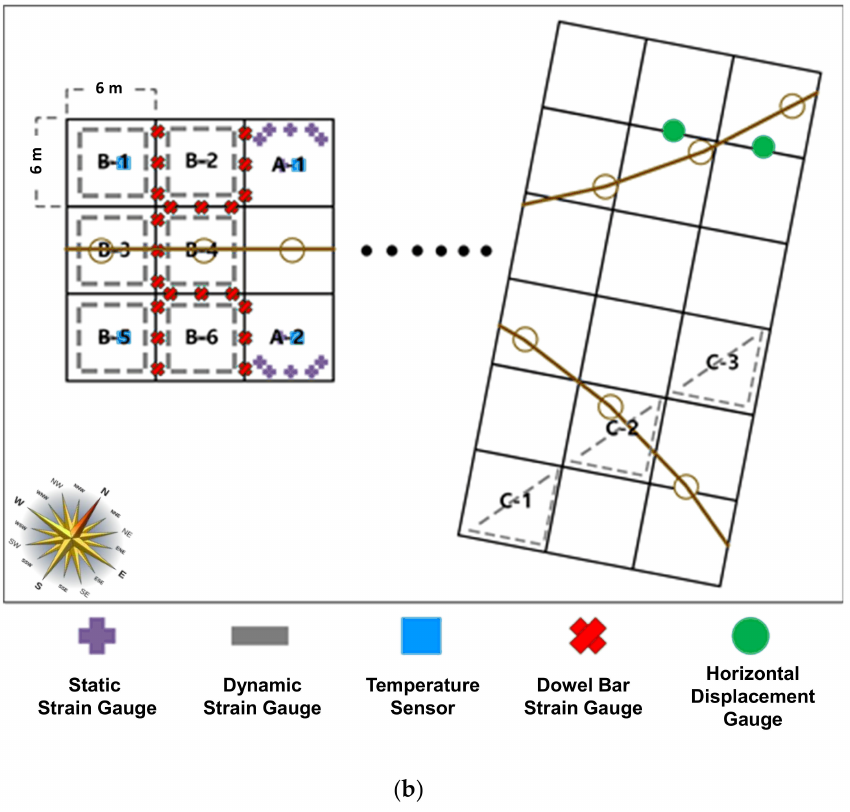
Figure 2. Location of the instrumented slabs: ( a ) location and ( b ) instrumented slabs. Table 1. Mixture proportions of a concrete